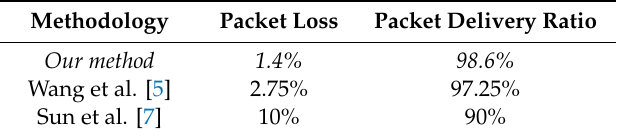
Table 2. Percentage of packet loss with 100 nodes.